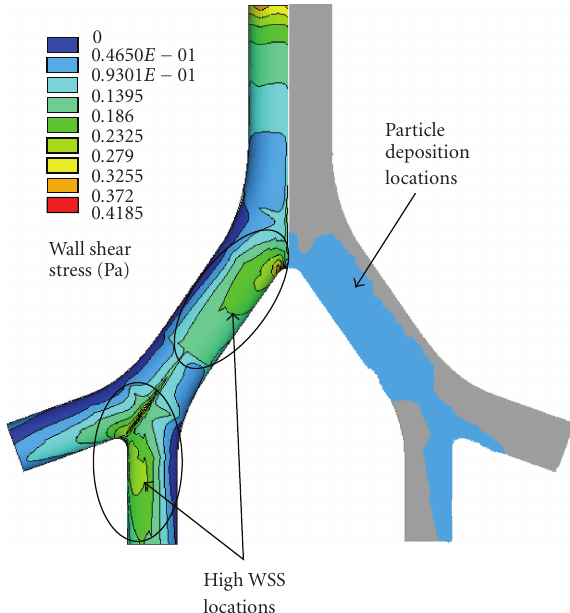
Figure 8: A distribution of wall shear stress (WSS) and locations of particle deposition in the airway generations 3 to 5 from the previous study by Longest and Vinchurkar [26].